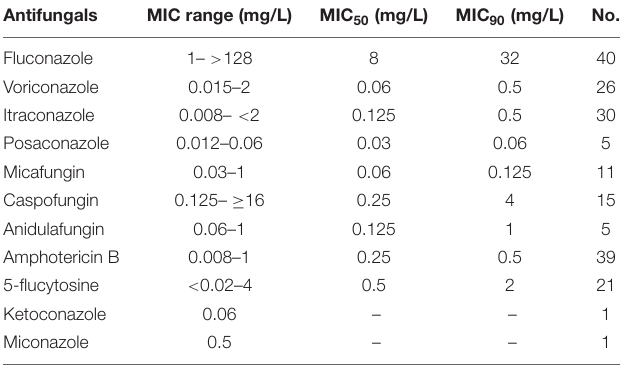
TABLE 2 | Antifungal susceptibility profiles of K. ohmeri